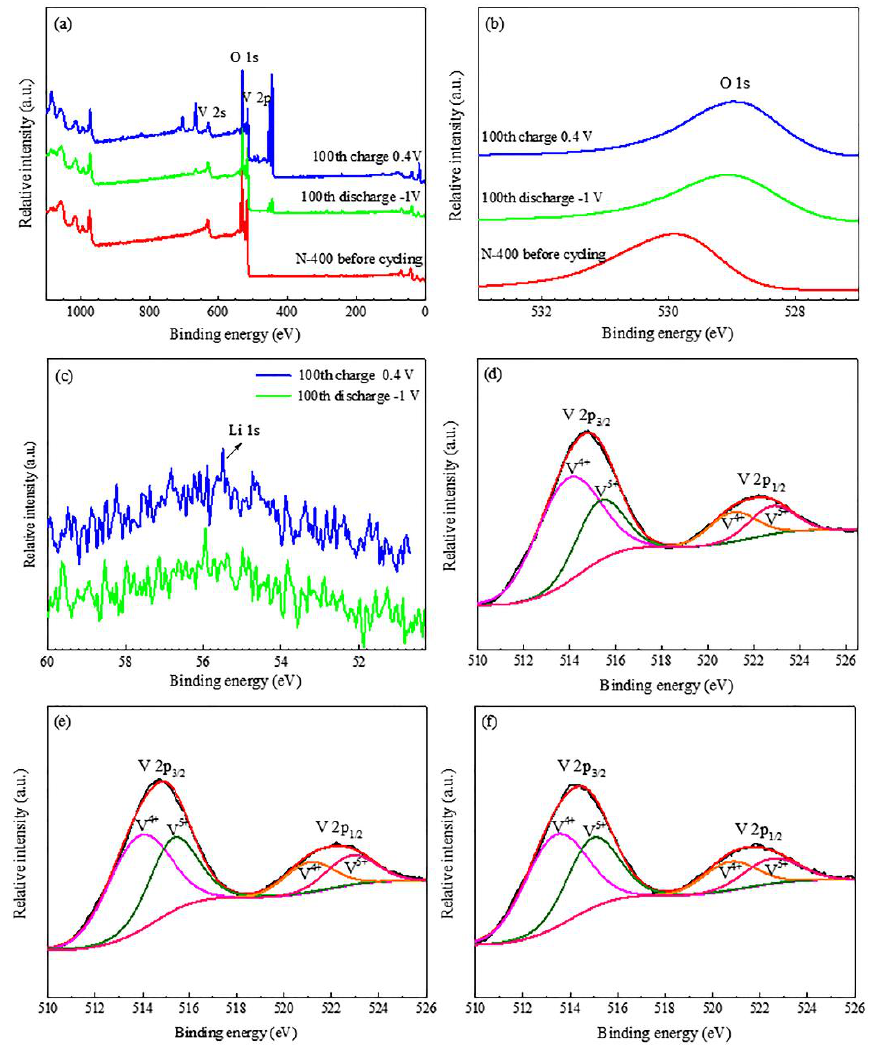
Figure 12. XPS spectra of the N − 400 film: XPS spectrum before and after 100 cycles ( a ); O 1s before and after 100 cycles ( b ); Li 1s before and after 100 cycles ( c ); V 2p before cycling ( d ); after 100th discharge state ( e ); after 100th charge state ( f ).